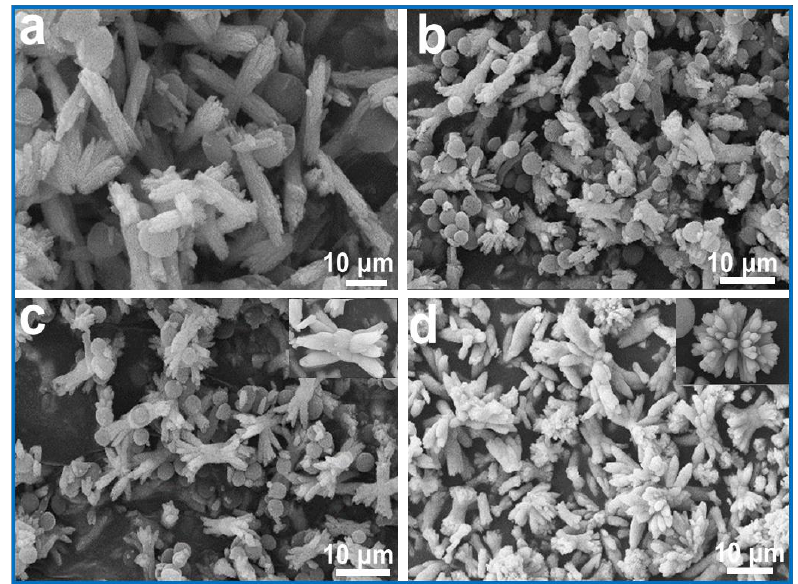
Figure 5. Typical SEM images of SrCO 3 obtained at the mineralization time of 6 h with a Nano-MMT concentration of 2 mL/L ( a ), 4 mL/L ( b ), 6 mL/L ( c ) and 8 mL/L ( d ), respectively.